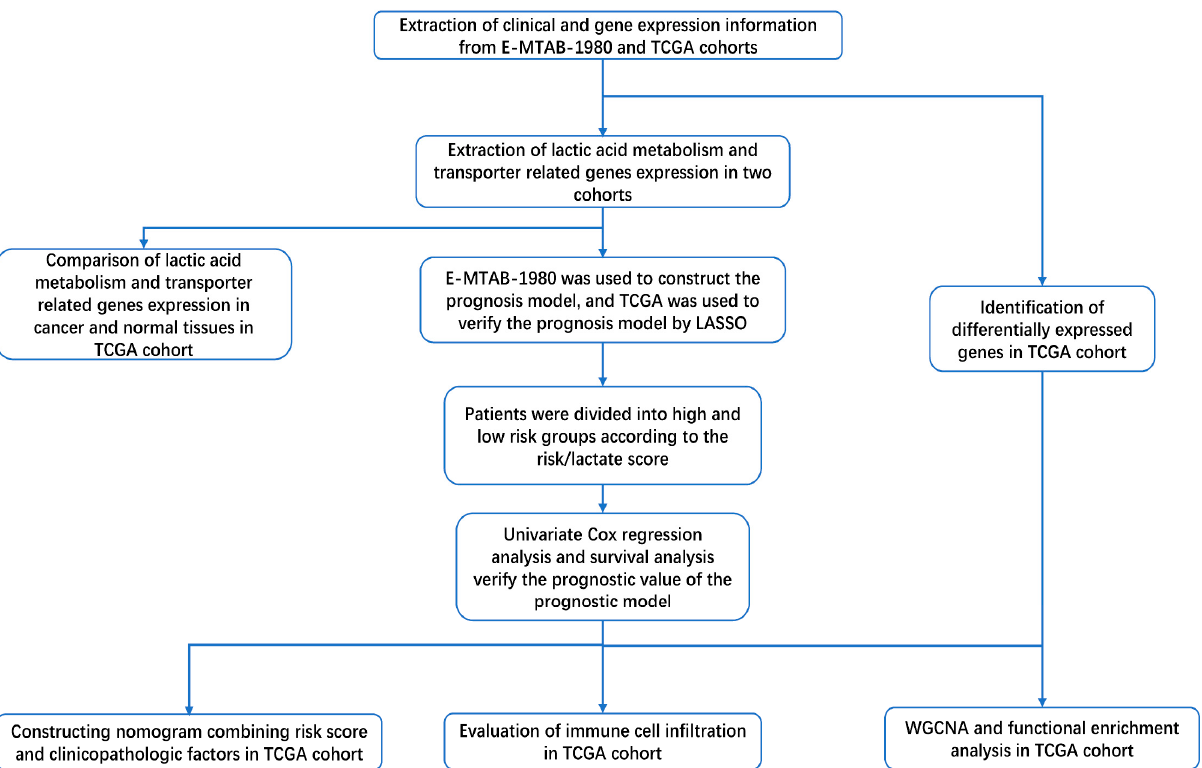
Figure 1. The workflow of this